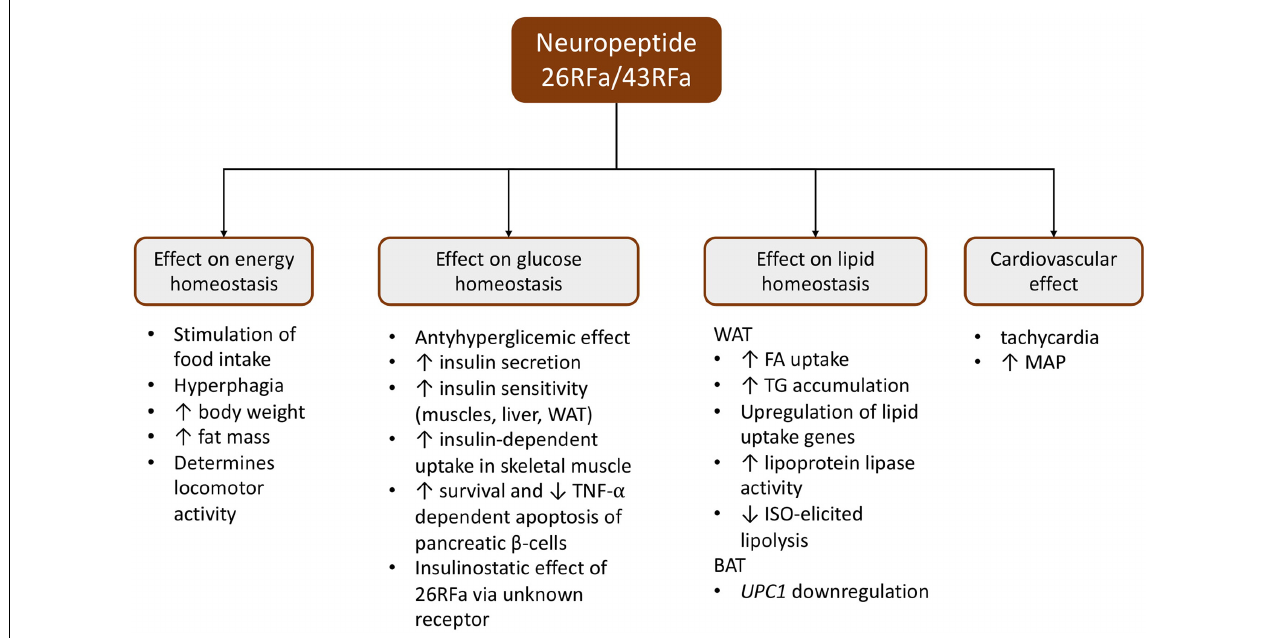
FIGURE 1 | Schematic presentation of the pleiotropic effect of the 26RFa/43RFa system. BAT, brown adipose tissue; ISO, isoproterenol; MAP, mean arterial pressure; TG, triglyceride; TNF- α , tumor necrosis factor α ; WAT, white adipose tissue; UPC1, uncoupling protein